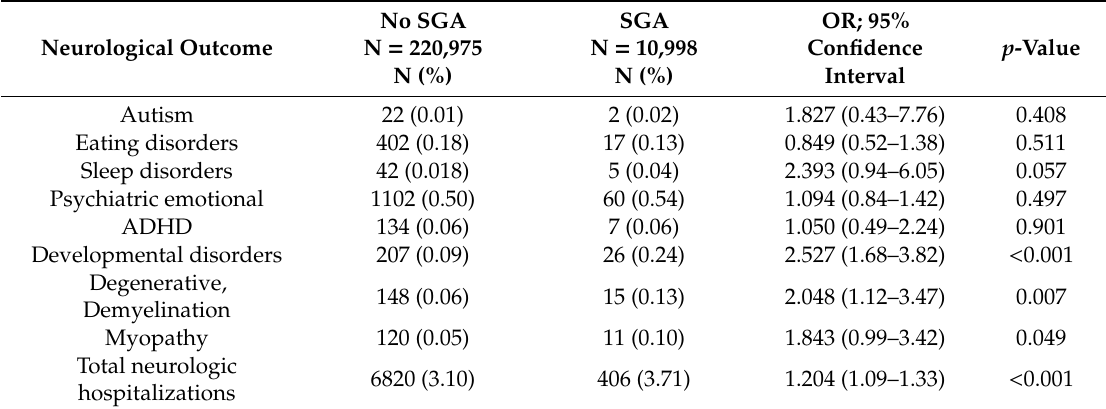
Table 2. Univariate analysis comparing the incidence of Long-term neurological disorders in children (up to the age of 18 years) born as SGA or non-SGA.